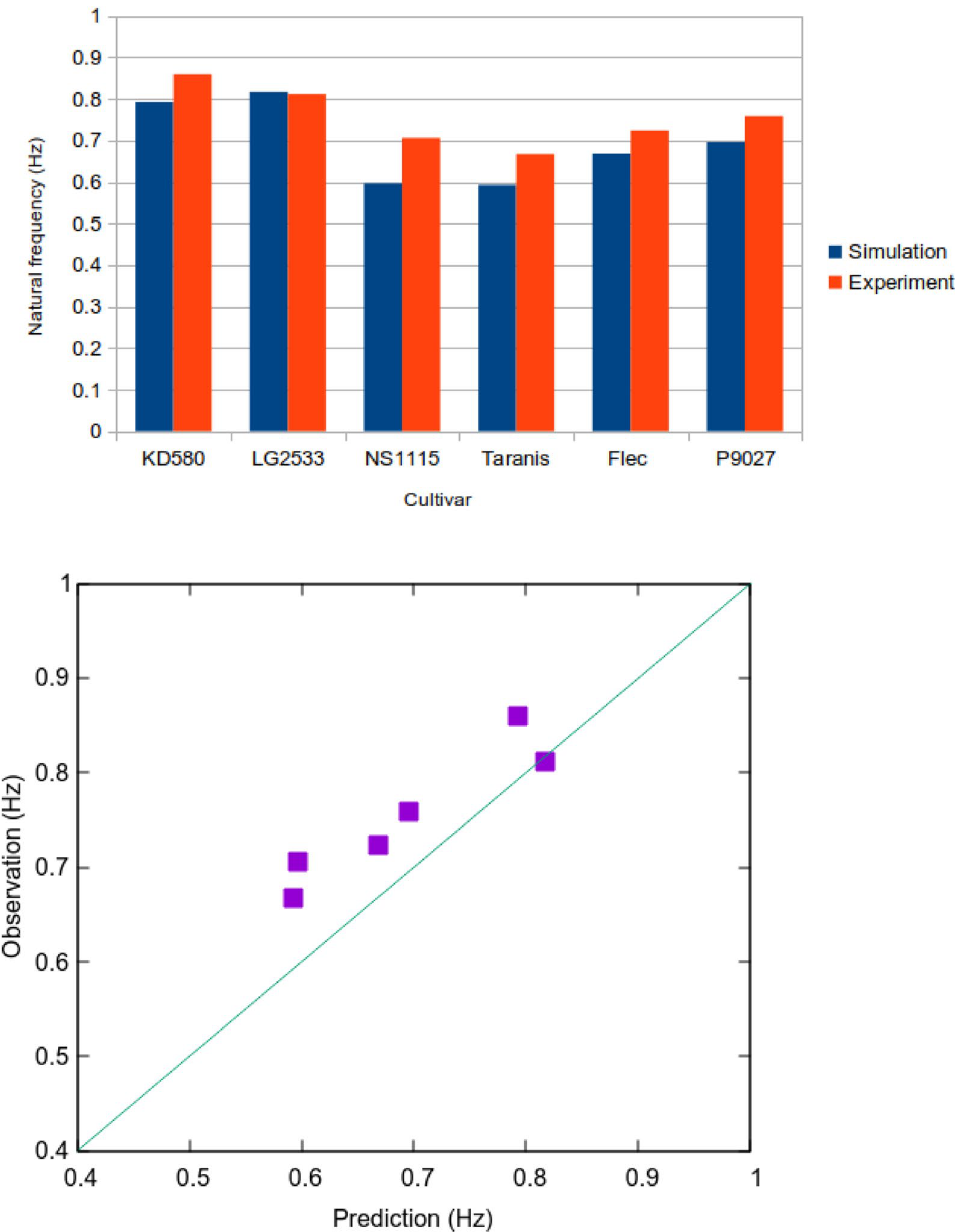
Figure 4. Natural frequency estimated by finite element analysis. The predicted natural frequencies of the six cultivars are mostly identical to one of the